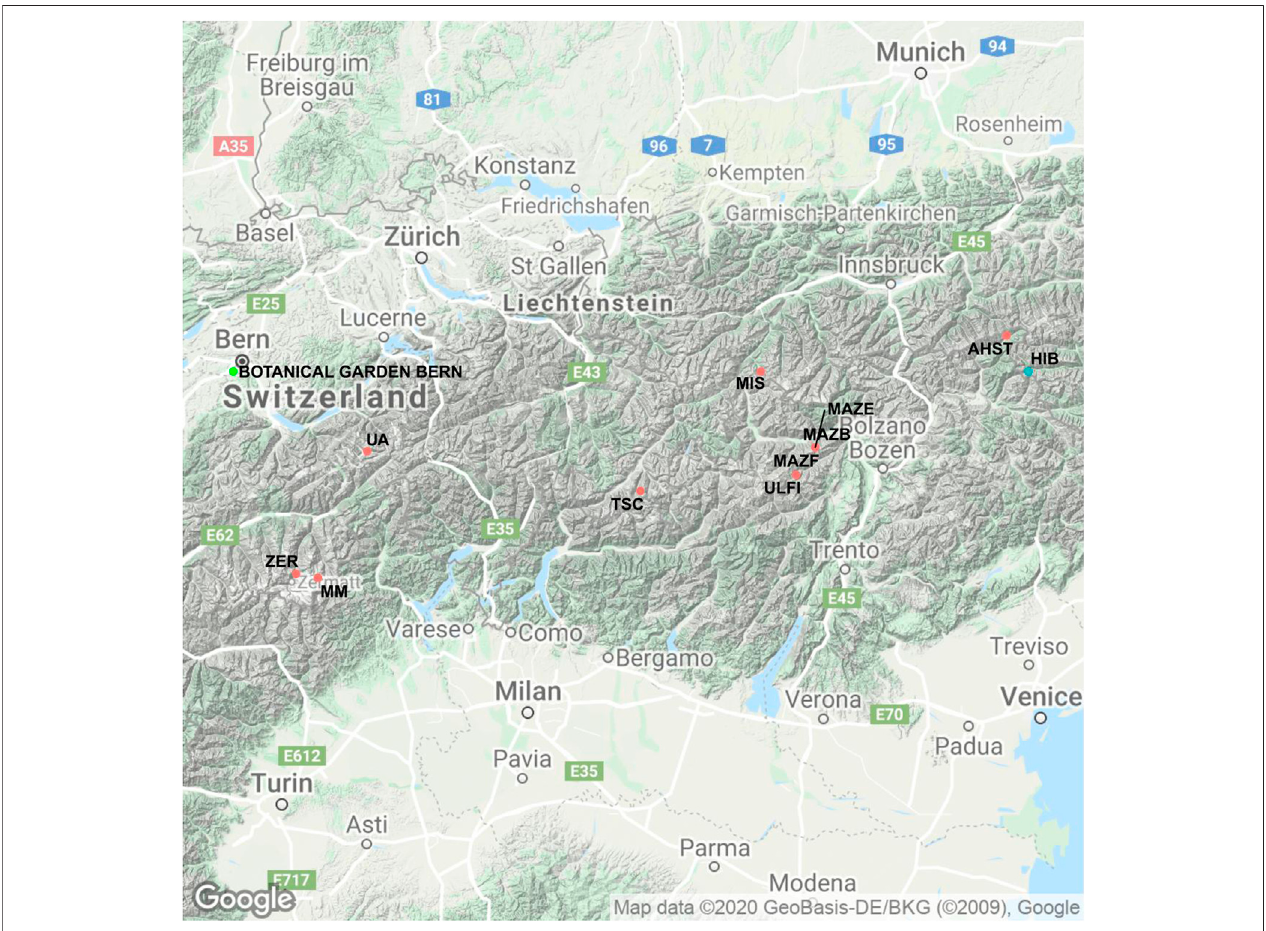
FIGURE1| Map ofthe12collectionsitesofthetreesdescribed in Figures2 , 3 . ThesitesarelocatedinSwitzerlandand Tyrol and theircodesused in Figure 2 are shown.Inbluearesitesatwhichlarchandcembranpinewerecollected,ingreenwherecembranpineandsprucewerecollected,inblackthesitesofthemodern(living) trees(withtheexceptionofVVR,whichisassite withboth livingand subfossilsamples),inlight-greenthelocation oftheBotanicalGarden inBern isillustrated.Detailsof site characteristics and of sample collection is given in Table 1 . (© Google Maps 2020)